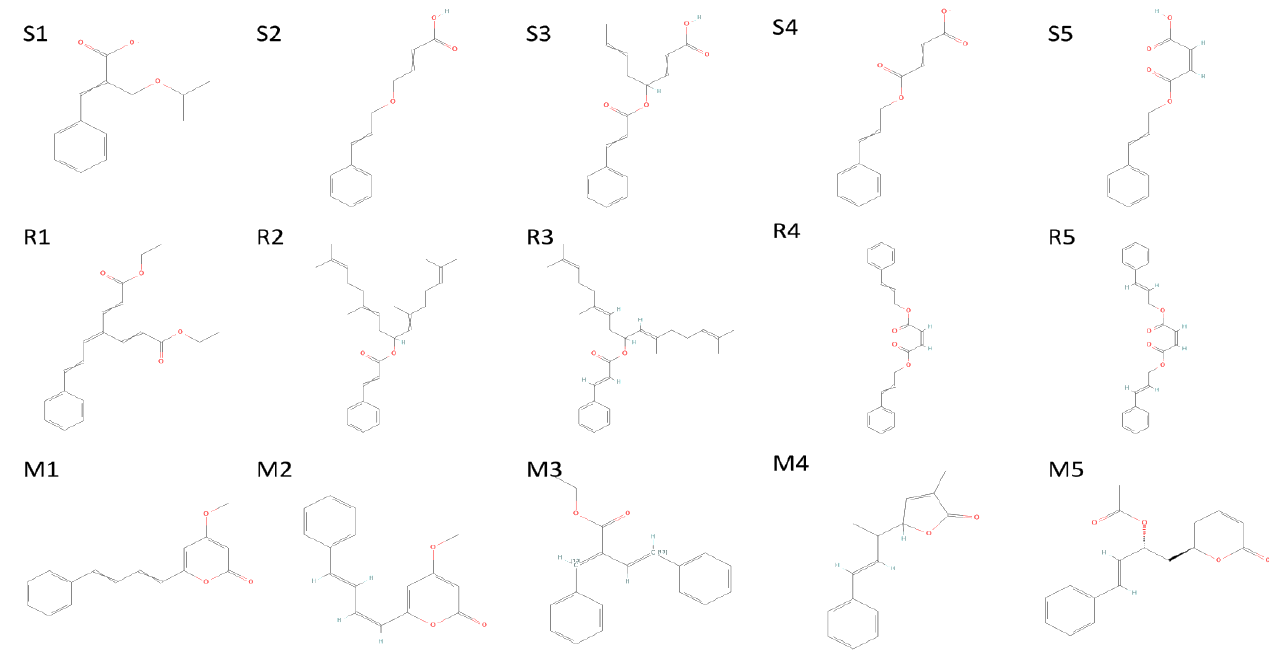
Figure 9. The 5 highest-ranked compounds of spike glycoprotein ( S1 – S5 ), RDRP ( R1 – R5 ), and main protease ( M1 – M5 ); their two-dimensional structures are depicted.